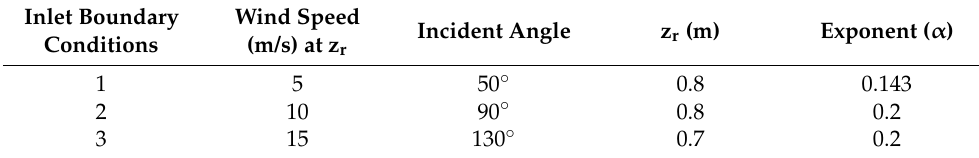
Table 2. Three inlet boundary conditions containing different wind shear effects.